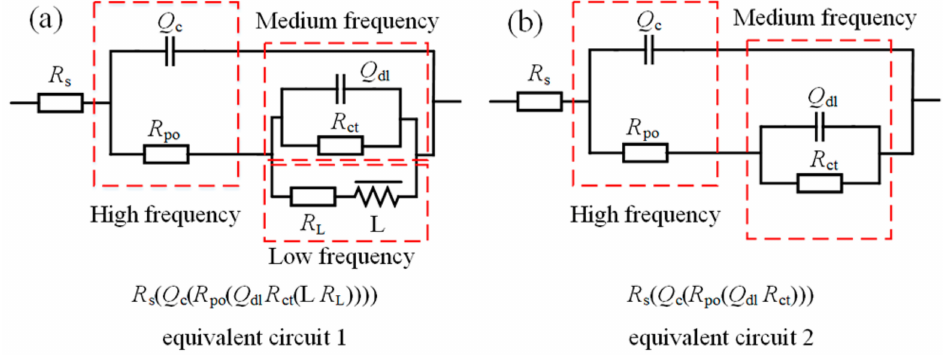
Figure 12. Two equivalent circuits used to fit the experimental electrochemical impedance spectroscopy (EIS) data of di ff erent samples. Circuit characterized by ( a ) two capacitive semicircles and an inductance and ( b ) two capacitive